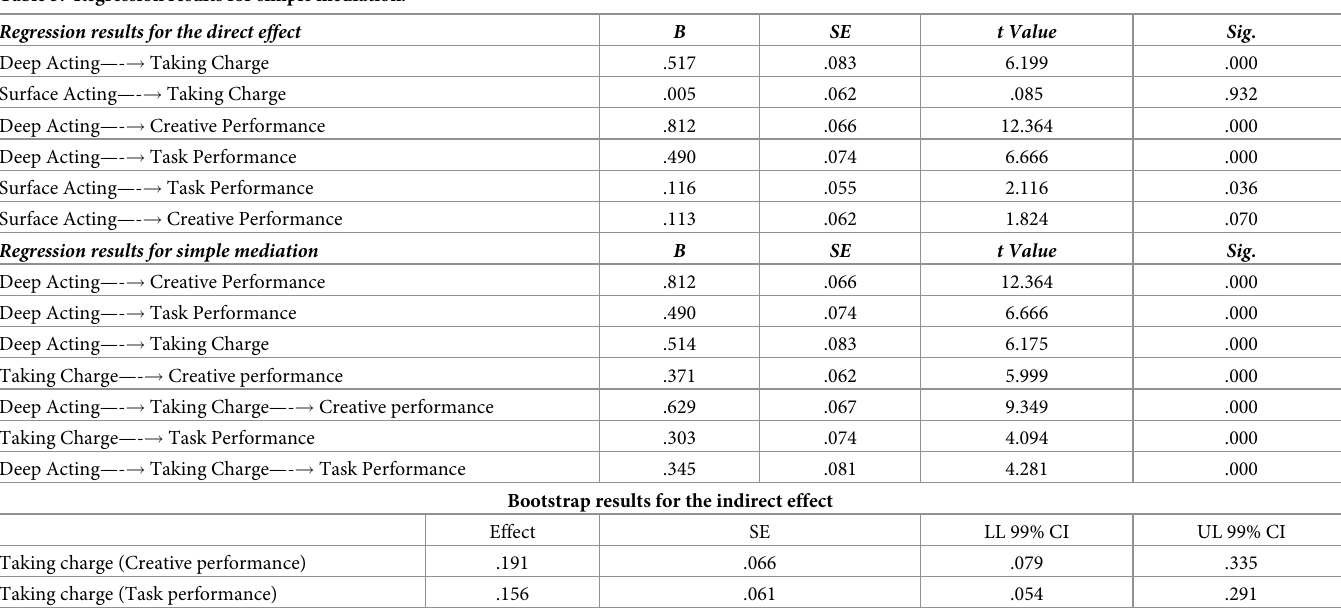
Table 5. Regression results for simple